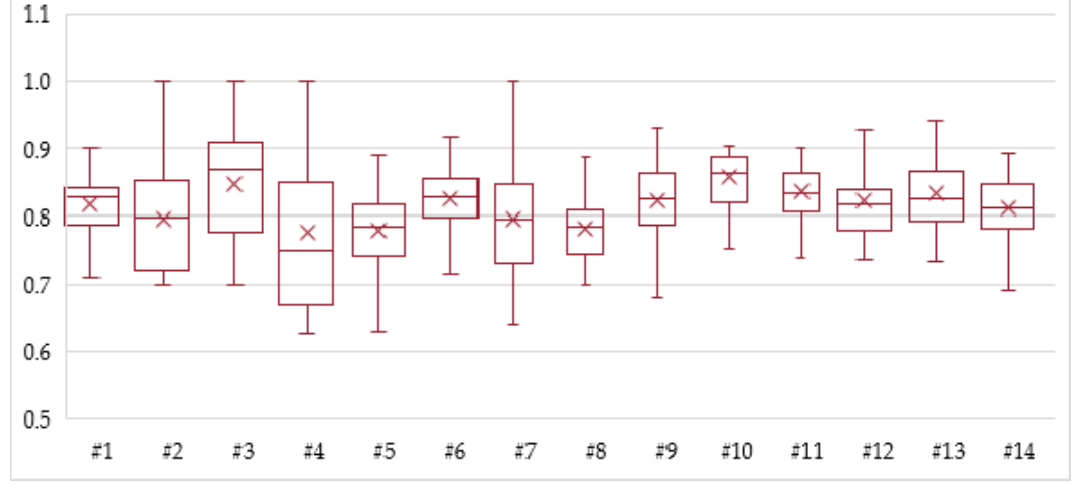
Figure 9. Best fitting statistic distribution. Table 6. Archetypes